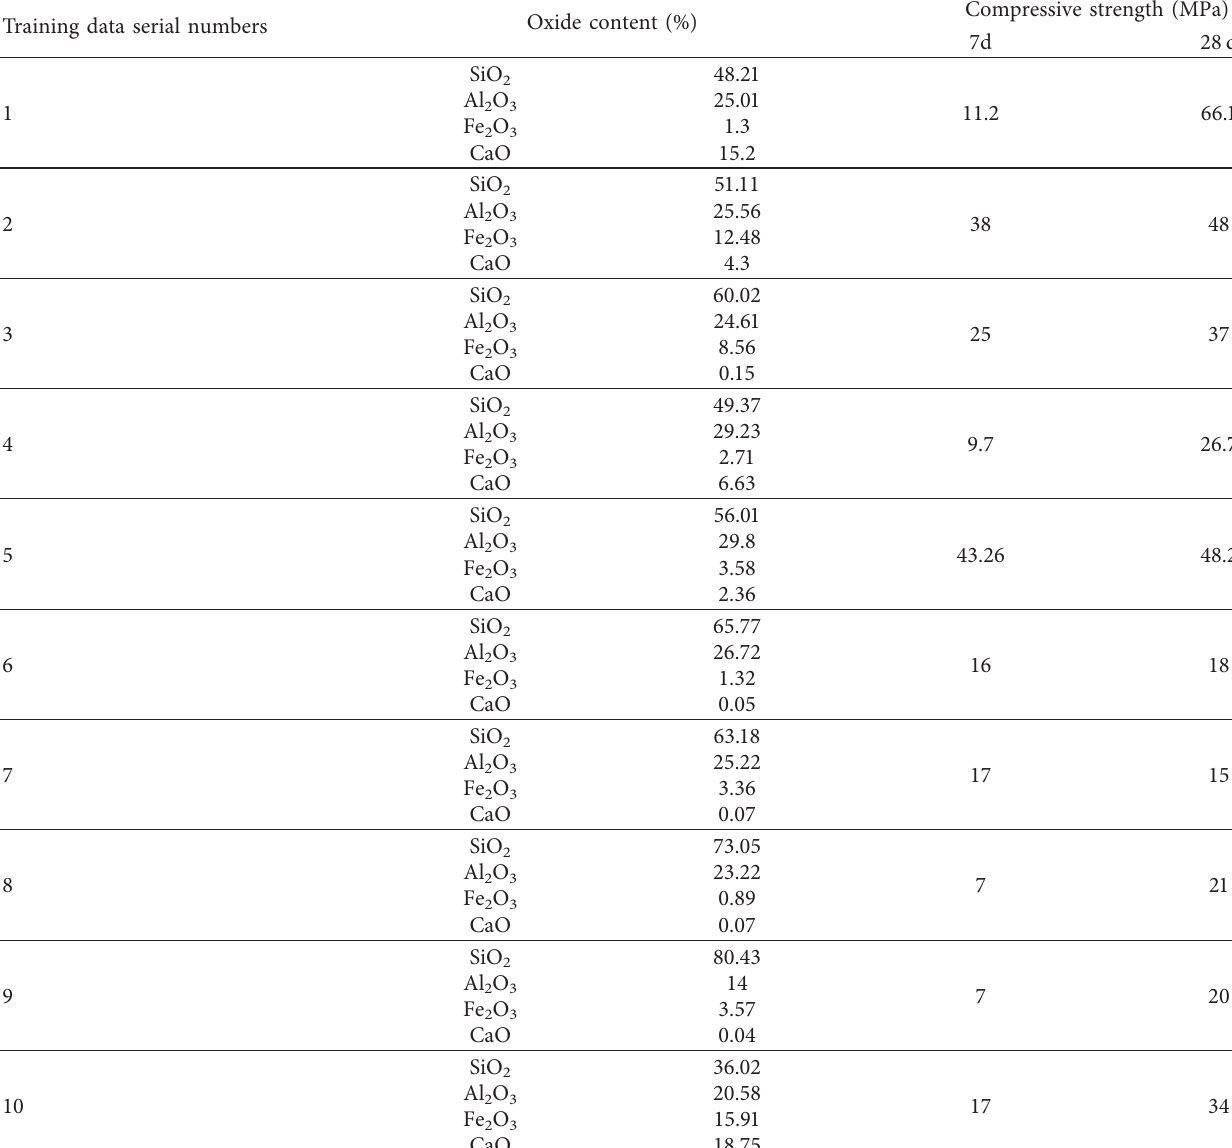
Table 5: Training